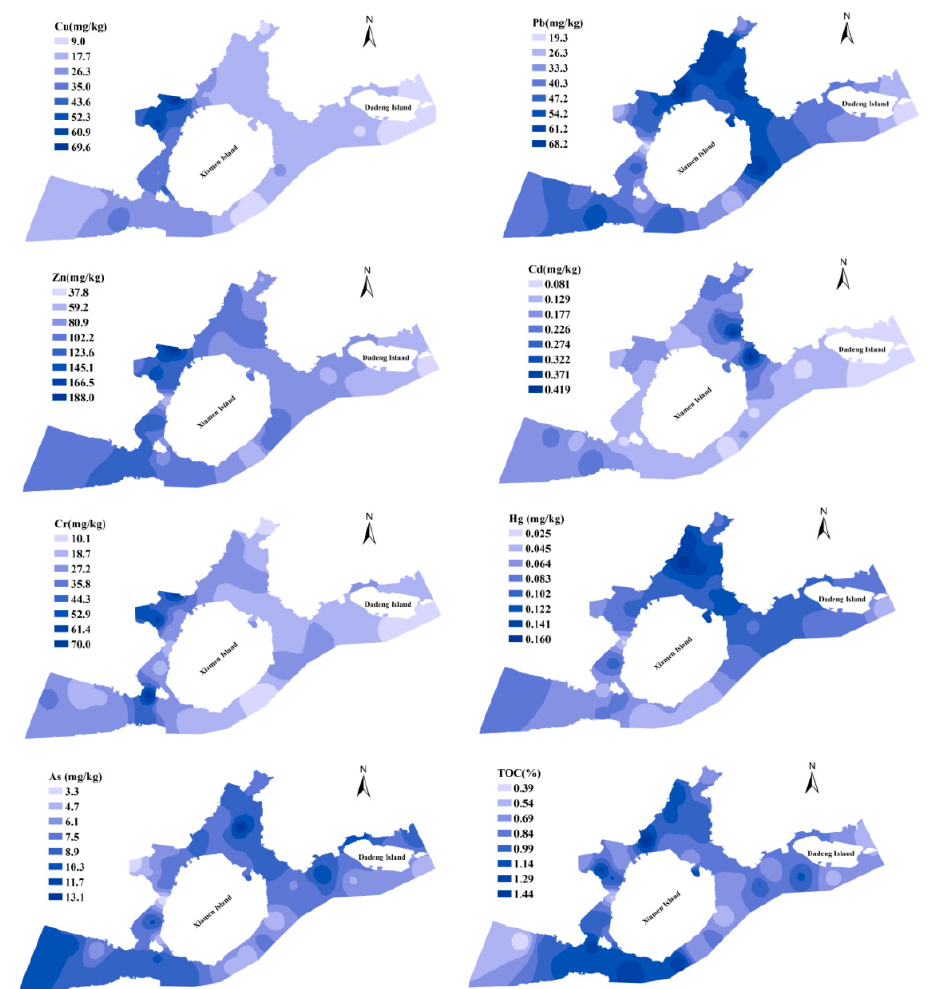
Figure 3. Spatial distribution of the PTEs contents (including Cu, Pb, Zn, Cd, As, Cr and Hg) and TOC in the surface sediments of Xiamen Bay.